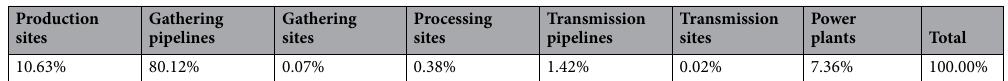
Table 5. Percentage share of the land use intensity across several stages of the fuel cycle of natural gas based on a 500-site study in the Barnett Shale of Texas 13 .